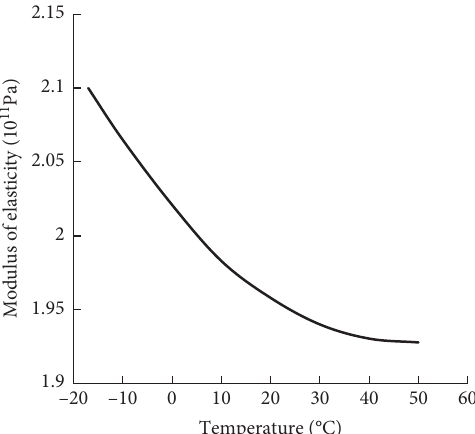
Figure 4: The relationship between elastic modulus of steel and temperature